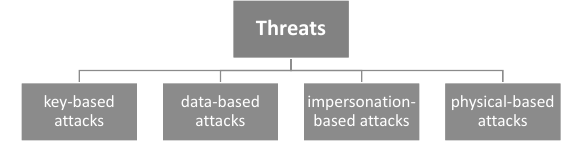
Figure 2. Classification of threats for SCADA system in Smart